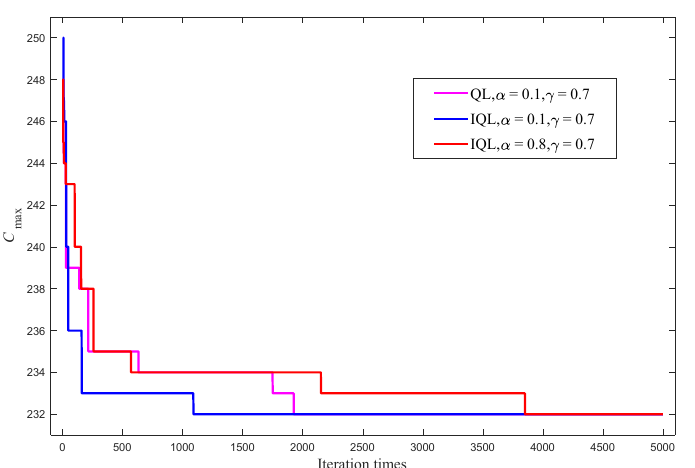
Figure 4. Criterion step of optimal solution under different parameters, before and after the algorithm improvement.